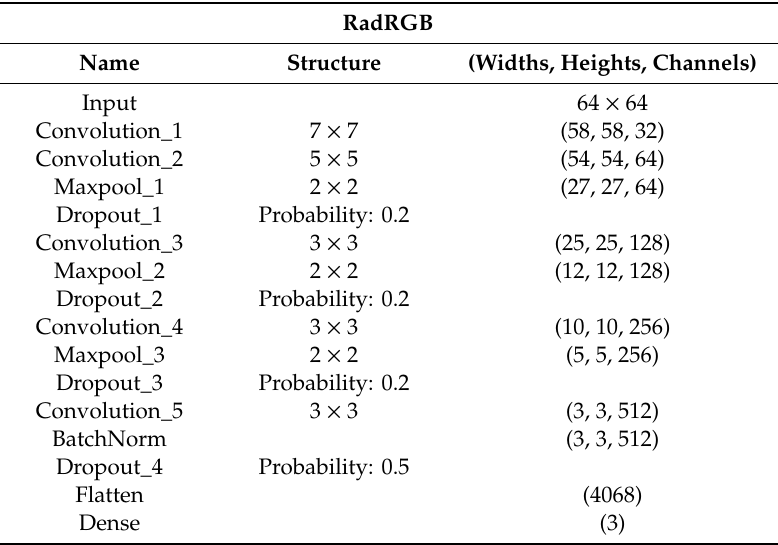
Table 2. A comprehensive description of the proposed RadRGB architecture.